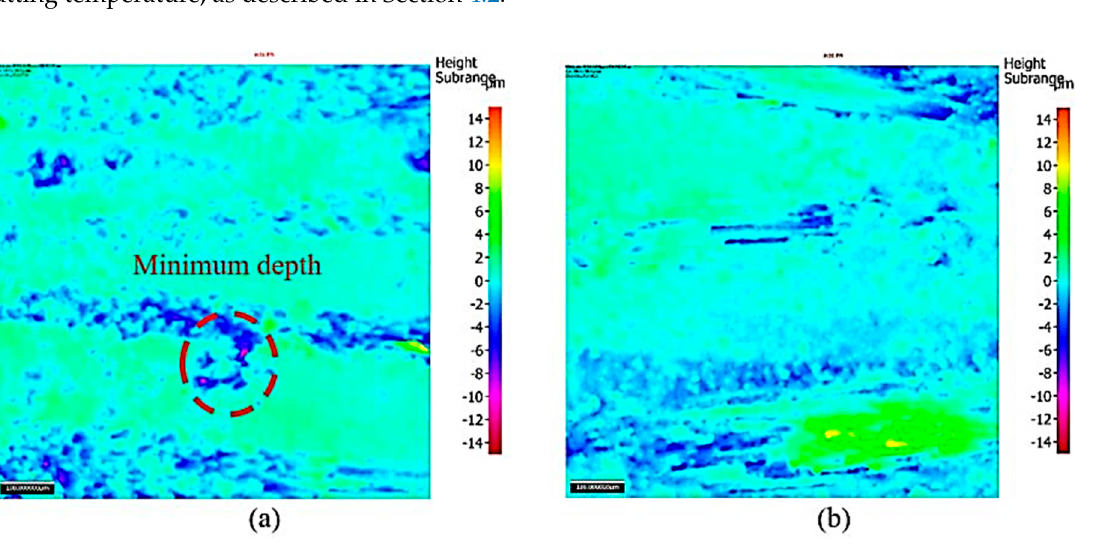
Figure 15. The SEM examination of HF-VAD machined hole at f = 0.075 mm/rev and N = 3000 rpm on the exit surface for ( a ) F = 1500 Hz and ( b ) F = 2150 Hz.